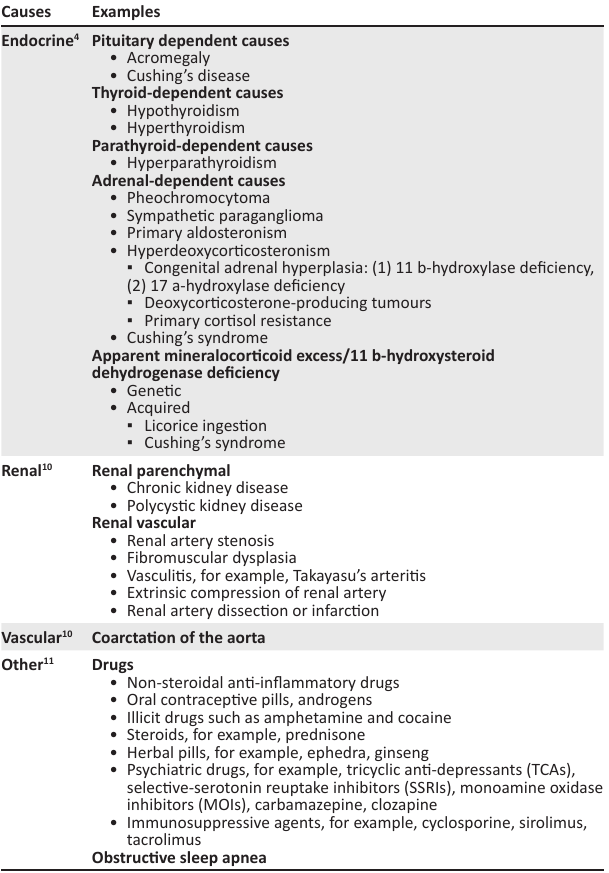
TABLE 1: Endocrine and other causes of secondary